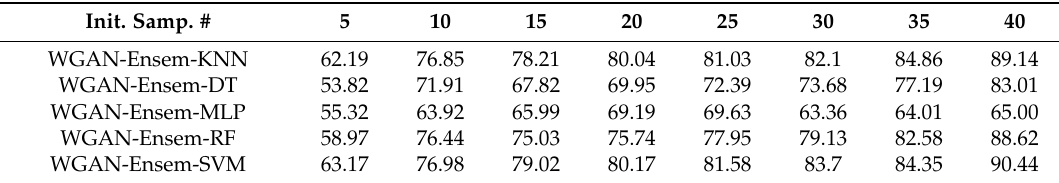
Table 5. The fault diagnosis accuracy rates (%) with different classifiers using WGAN-ensemble to generate artificial training dataset. Init. Samp.